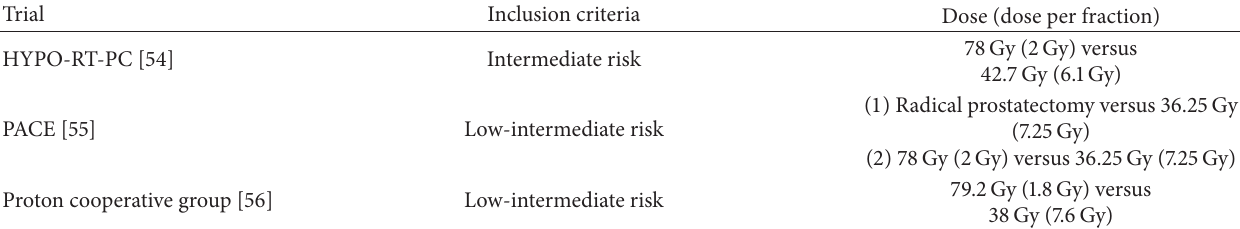
Table 3: Randomized controlled trials evaluating the efficacy and toxicity of extreme hypofractionated radiation